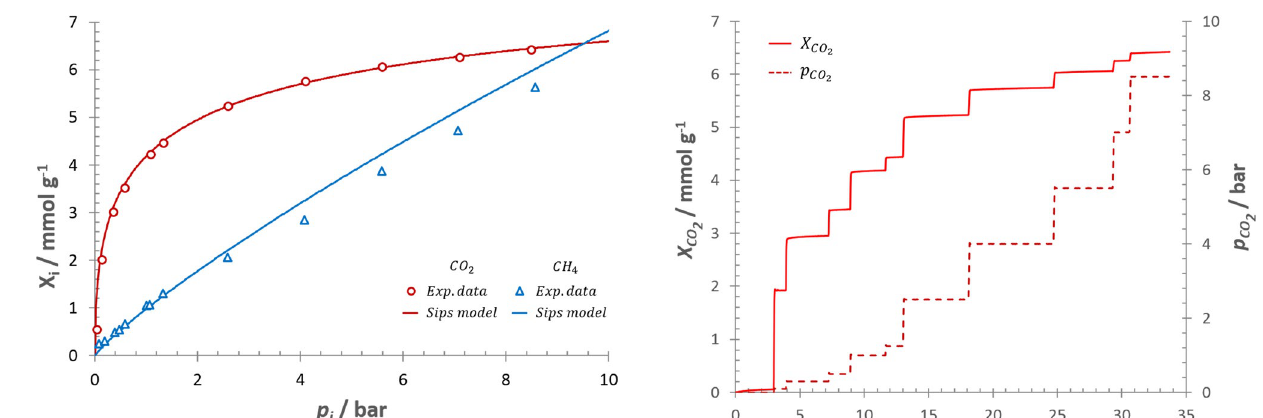
imposed onto Ni-MOF-74 at T = 303.15 2